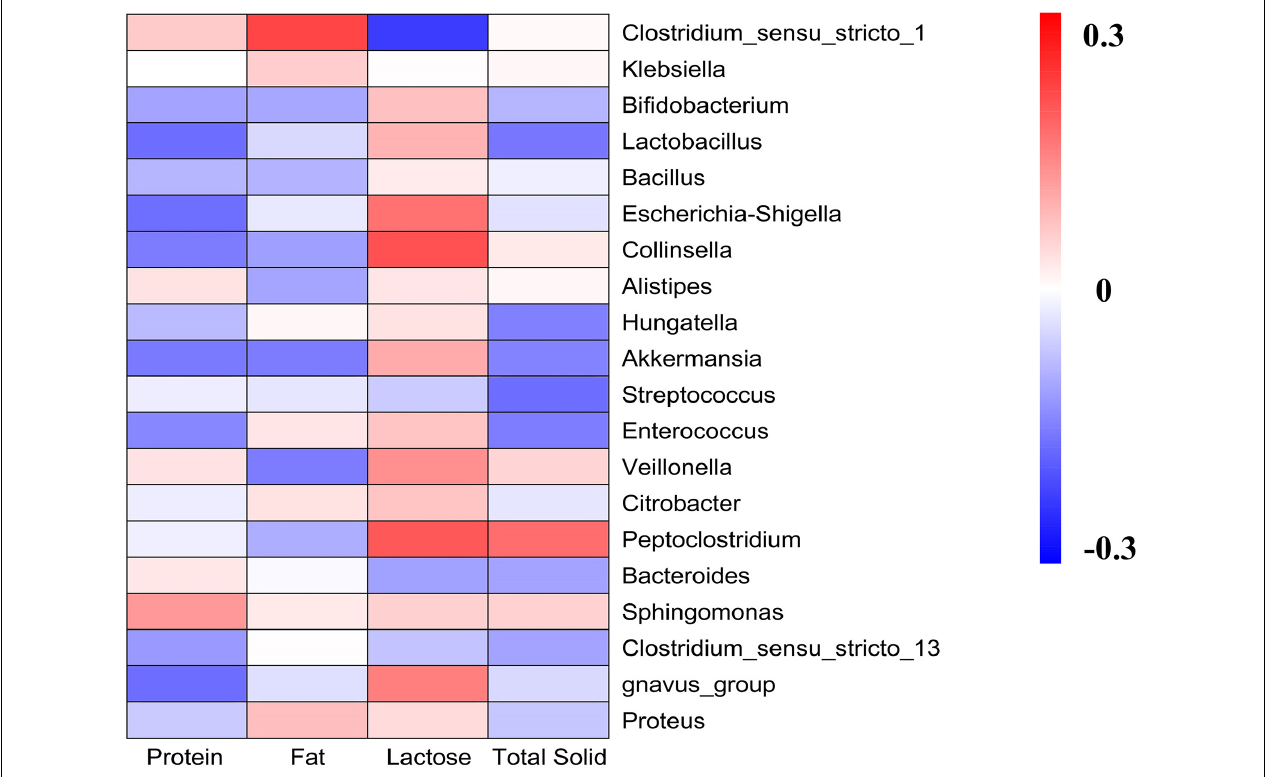
FIGURE 6 | Heatmap analyses. It represented the correlation between gut microbiota and the main components of